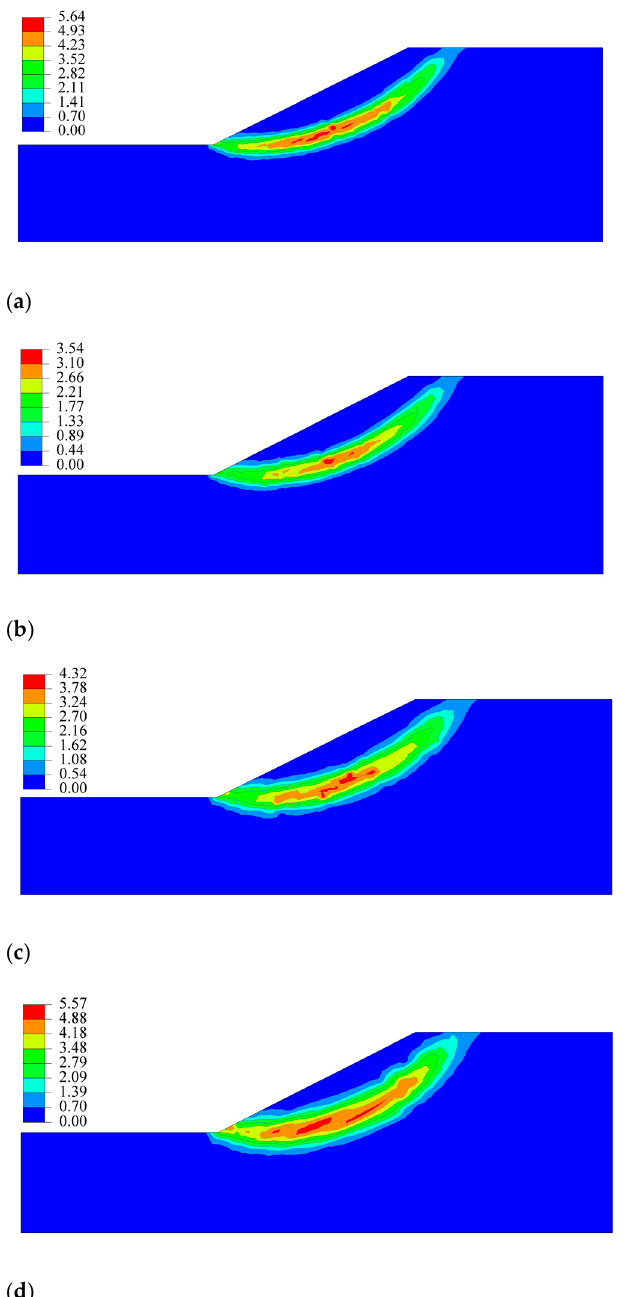
Figure 5. The contours of equivalent plastic strain by the SRM. ( a ) Model A; ( b ) Model B; ( c ) Model C; ( d ) Model D.